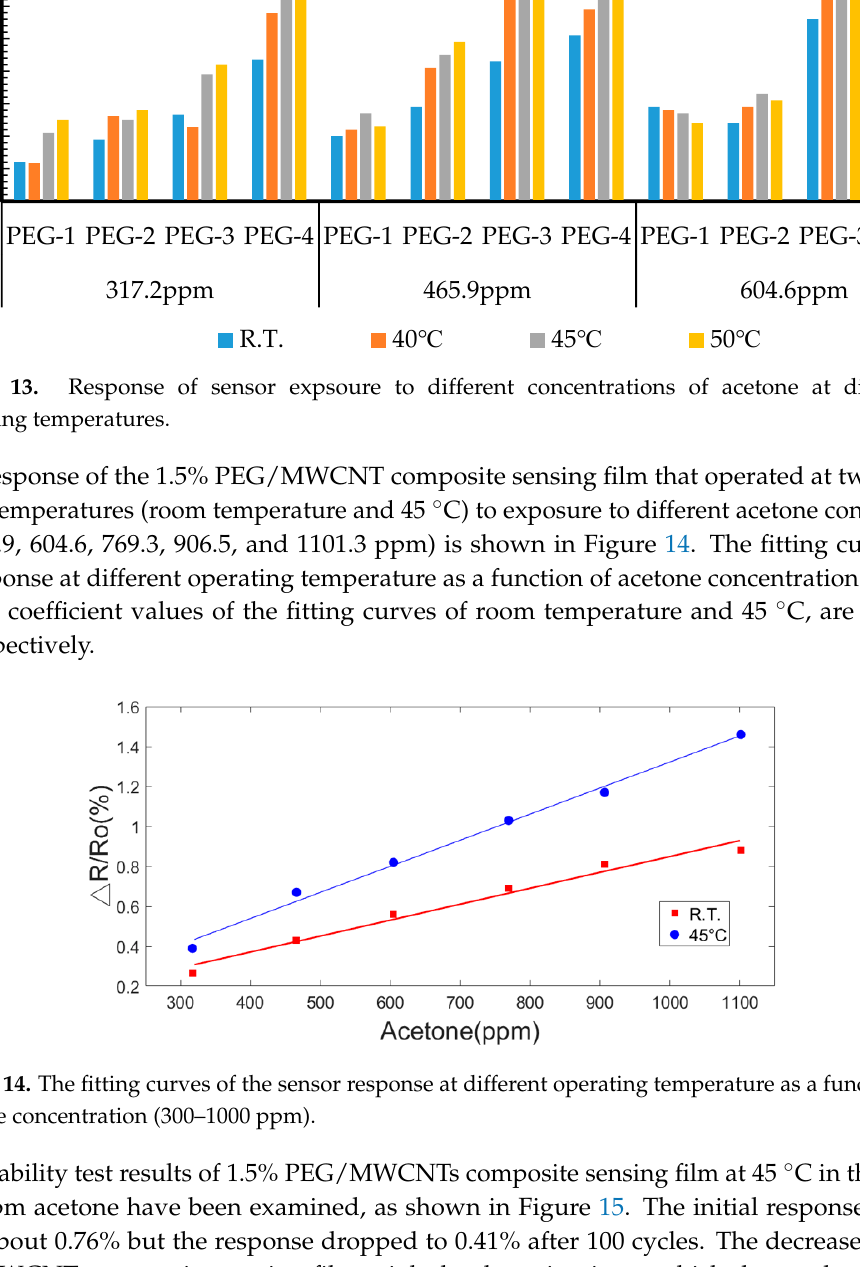
10 of 13 Figure 12. Response of sensor expsoure to 6294.3 ppm acetone at different operating temperatures. ( a ) room temperature (25 °C), ( b ) 40 °C, ( c ) 45 °C, and ( d ) 50 °C. 4.1. Sensor Response of Acetone with Thermal Treatment The operating temperature and the acetone vapor concentration deeply affected the response of the PEG/MWCNTs composite sensing material. Therefore, the acquirement of sensor resistance is a straightforward method to observe the phenomenon, which provides much information including the kinetics of atmospheric oxygen adsorption, electron-donating/withdrawing molecules via Van der Waals force, and donor–acceptor interactions [32,33]. To observe the optimum working temperature, the response of the gas sensor fabricated by PEG/MWCNTs was examined as a function of the operating temperature for exposing to 317.2, 465.9, and 604.6 ppm diluted acetone vapors, as shown in Figure 13. The acetone response was increased as a function of the concentration of PEG. This means that the good interaction of PEG surface with the target gas molecules induced the charge transfer in MWCNTs. The response was increased and then achieved its maximum value at 45 °C for each concentration of acetone, possibly because the moderate working temperature provided the